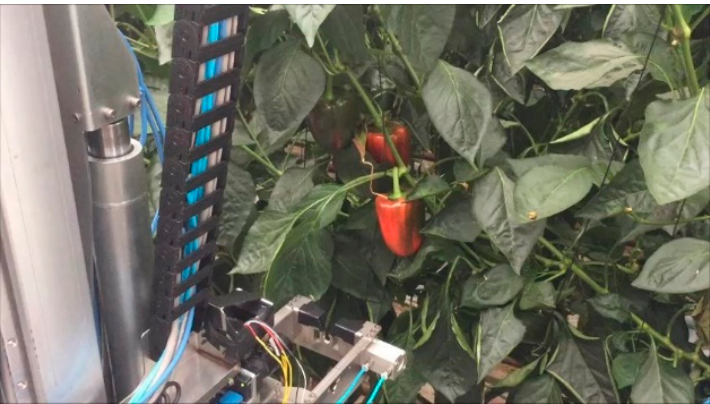
Figure 15. A scene of the field experiment.